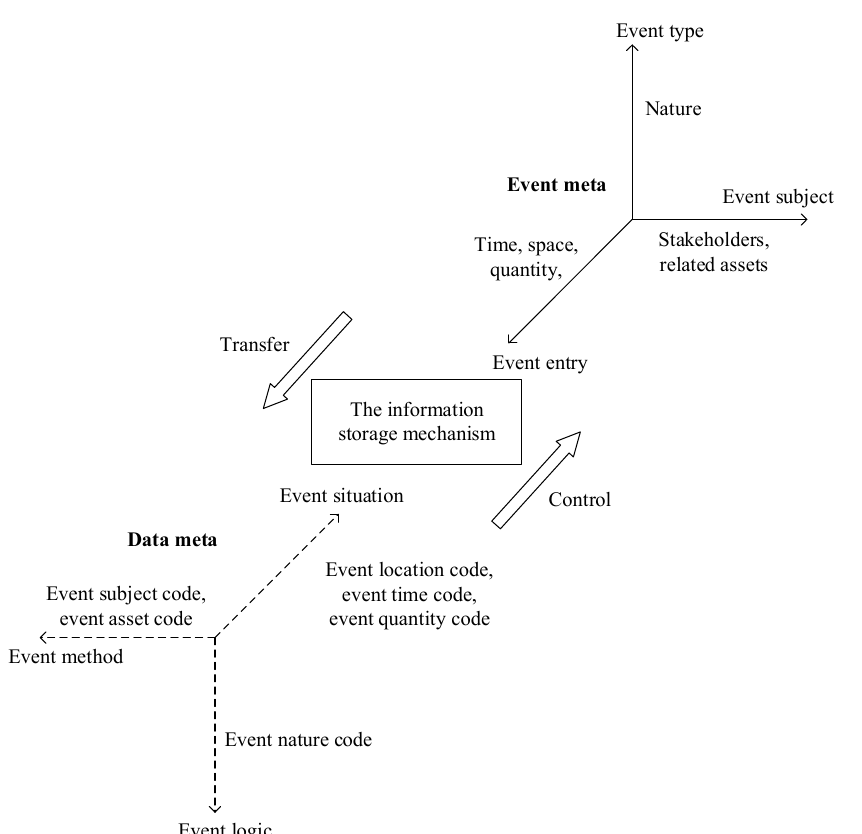
Event code3Event code2 Event code4 Figure 6. Shili Mirrored Structure based on the information storage mechanism.